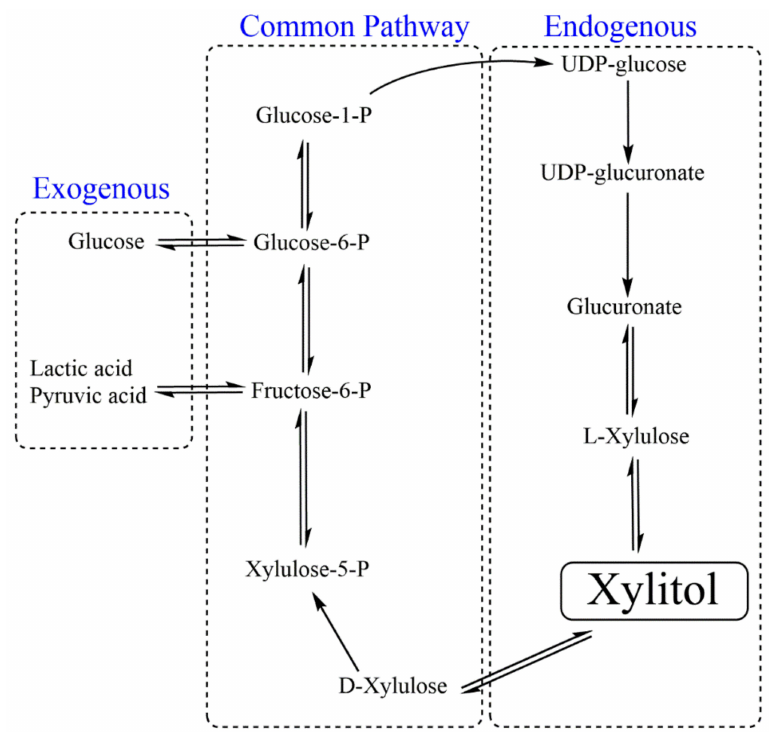
Figure 4. Metabolism of xylitol. Food and intracellular metabolism are two sources for xylitol. Xylitol consumed through food is referred to as exogenous xylitol and intracellularly-produced xylitol is endogenous xylitol. As shown in the figure, xylitol from both sources shares some common steps in